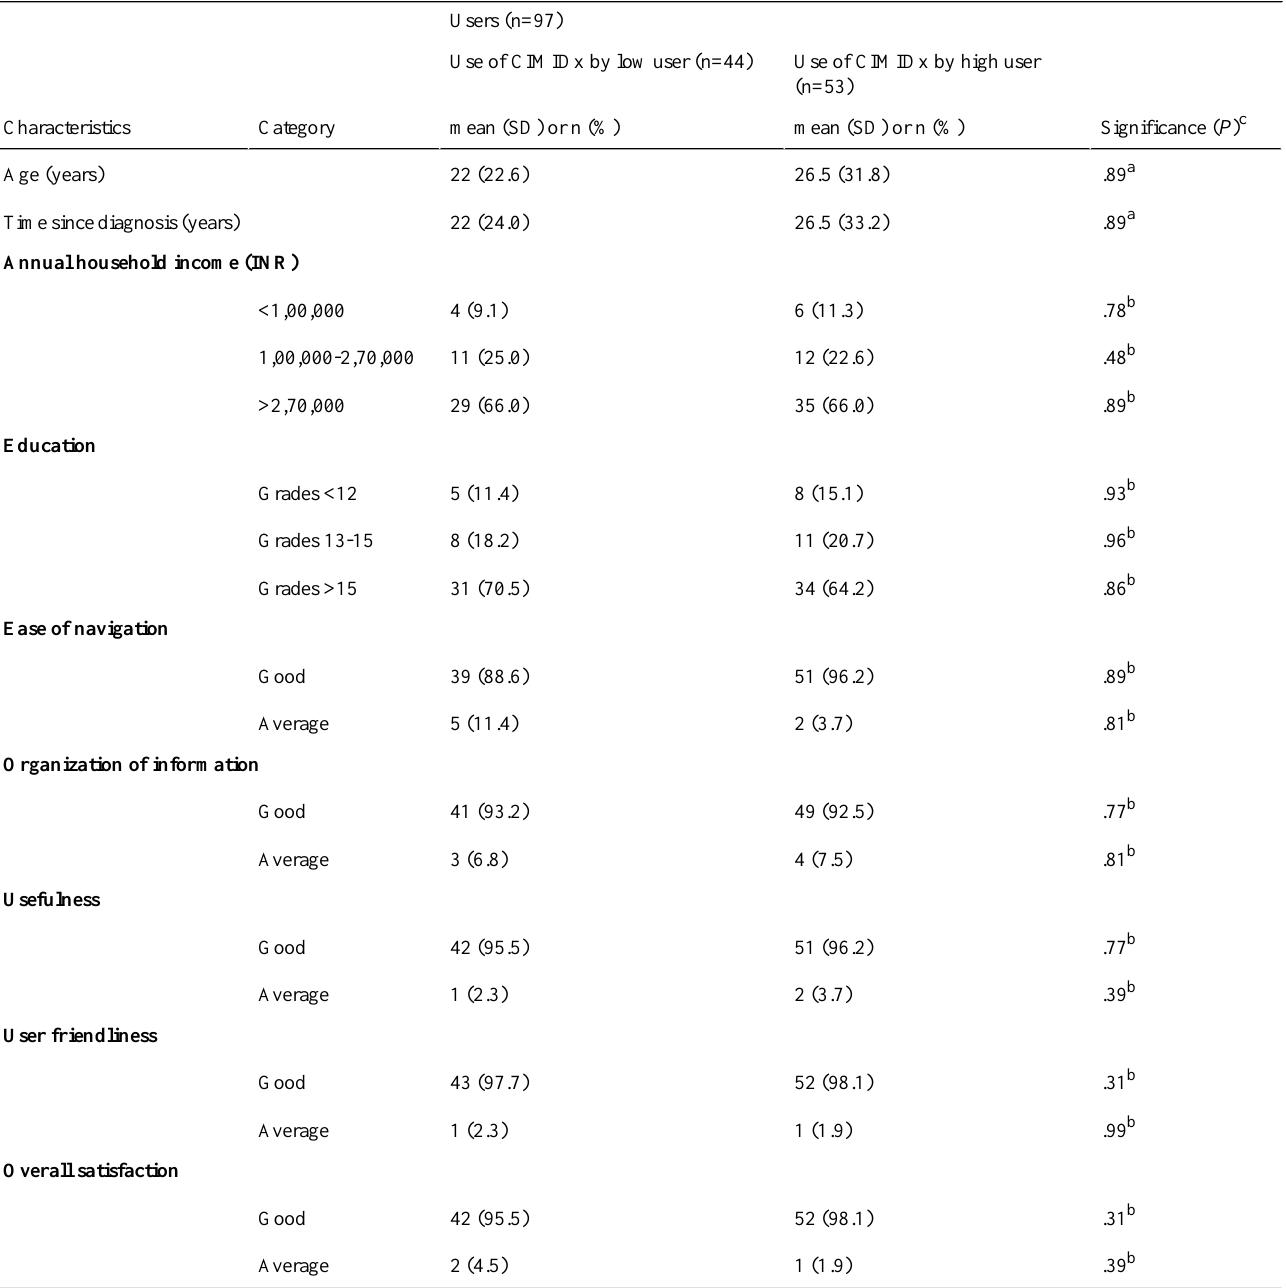
Table 5. Group characteristics (social, economic, and the usefulness of the CIMIDx prototype for the two user